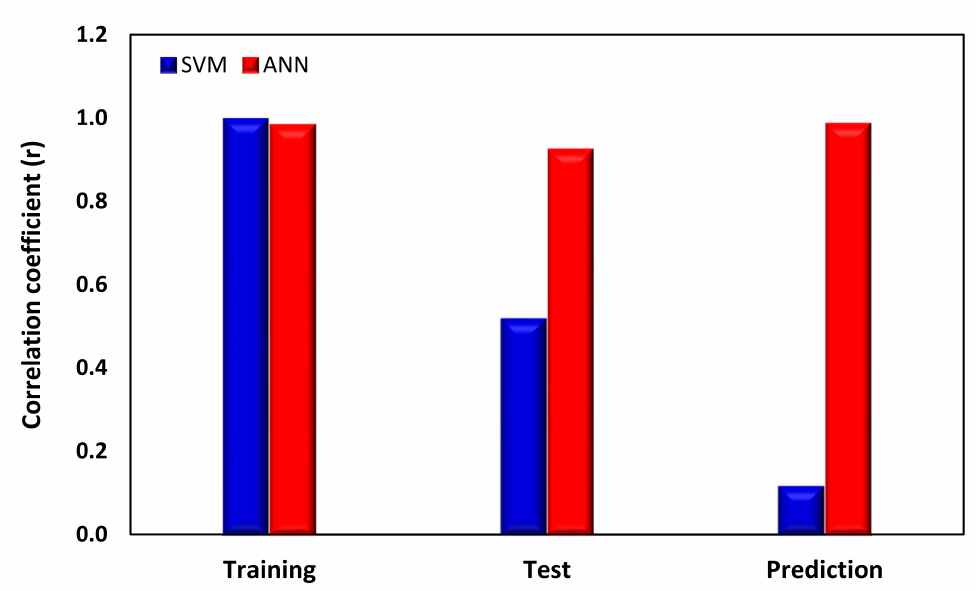
Figure 7. Comparative analysis of SVM and ANN